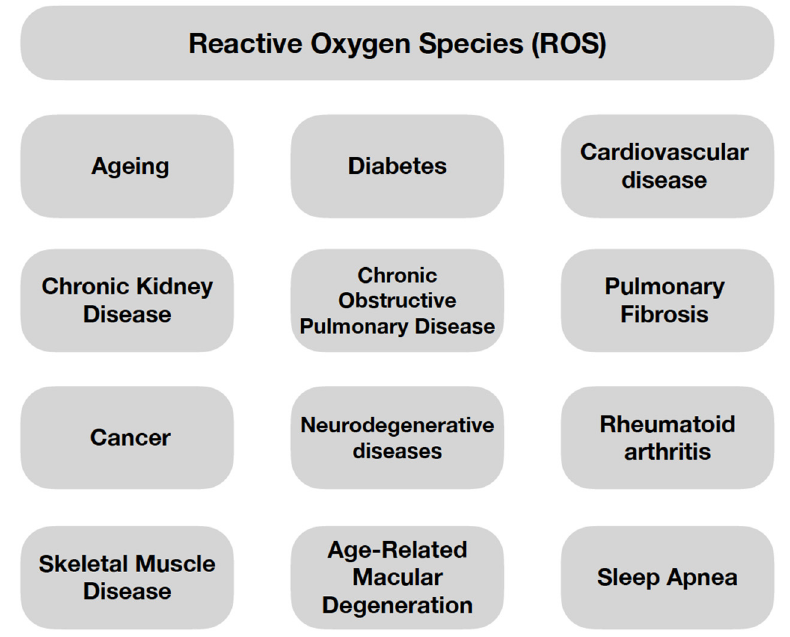
Figure 1. The Examples of Processes/Diseases Caused by Oxidative Stress [24,25].